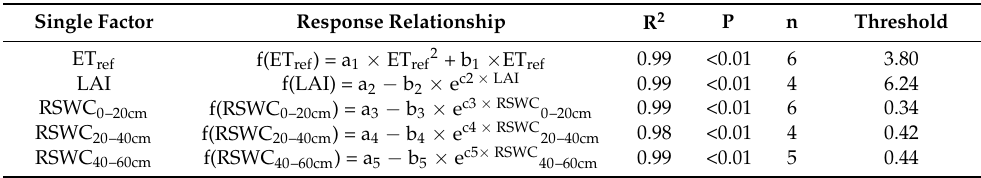
Figure 4. Response of T to different soil layers RSWC (0 – 20, 20 – 40, and 40 – 60 cm) from 2017 to 2019. Table 3. The response relationship of T to ET ref , LAI, and RSWC in different soil layers and their thresholds. Single Factor